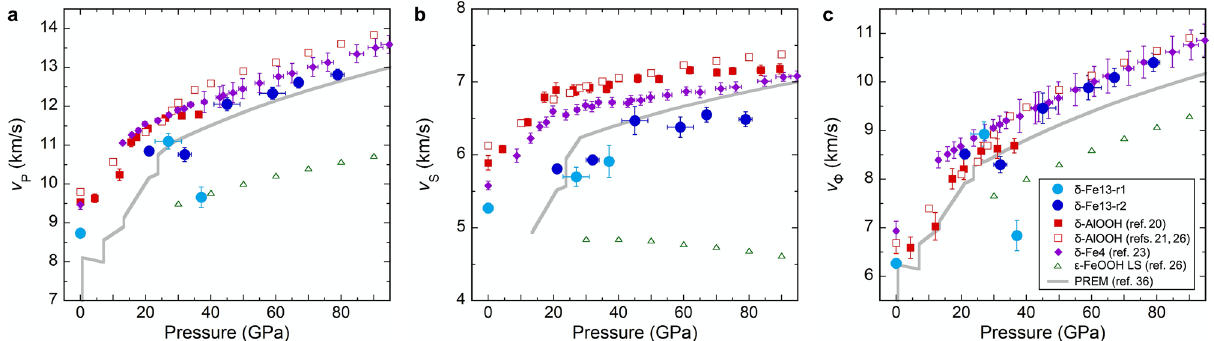
Figure 3. The elastic wave velocities of the δ-Fe13 samples computed using the natural abundance of Fe: (a) , v P , (b) , v S , (c) v Φ . Elastic wave velocities of other end-membered hydrous phases: δ-AlOOH 20,21,26 , δ-(Al 0.956 Fe 0.044 ) OOH (δ-Fe4) 23 , and ε-FeOOH with low spin state of Fe 3+26 are also shown. PREM is shown by gray lines 36 . The values indicated by solid and open symbols were obtained from room temperature experiments and calculations at 0 K, respectively. Abrupt reductions of v P and v Φ for the δ-Fe13 samples at 32 GPa and 37.1 GPa are due to the spin transition of Fe 3+22 . The numerical values for the data of δ-Fe13 samples in this figure are available in Table